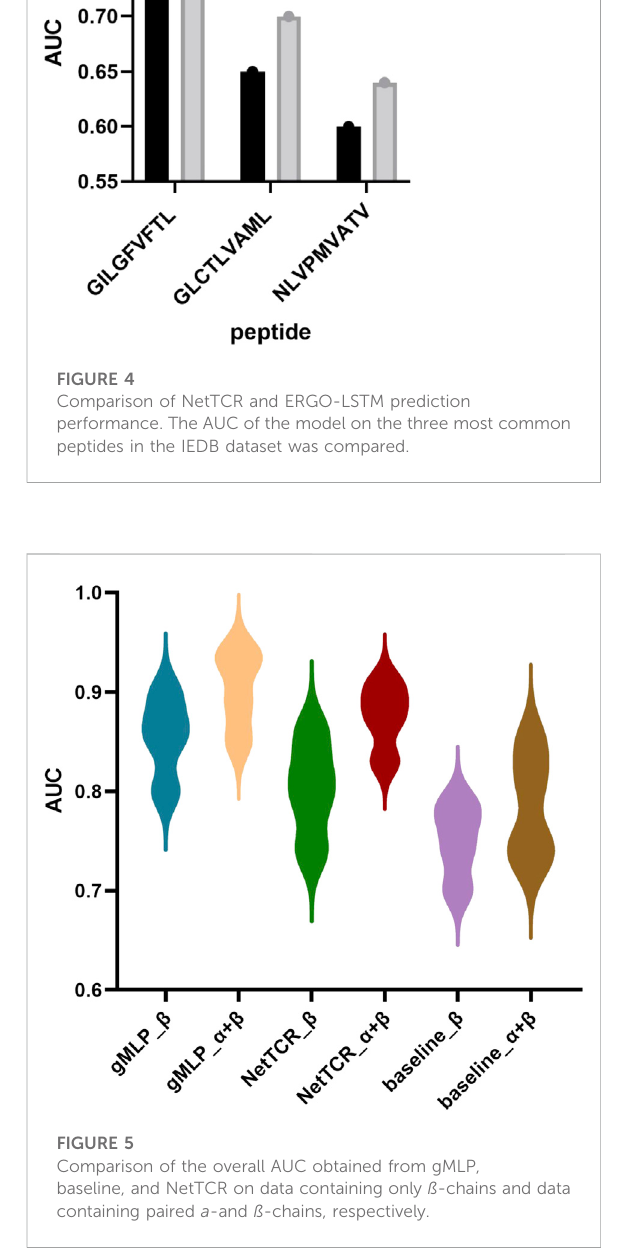
peptides of 9-mer length. Therefore, the dataset used all HLA- A*02:01 and 9-mer peptides.